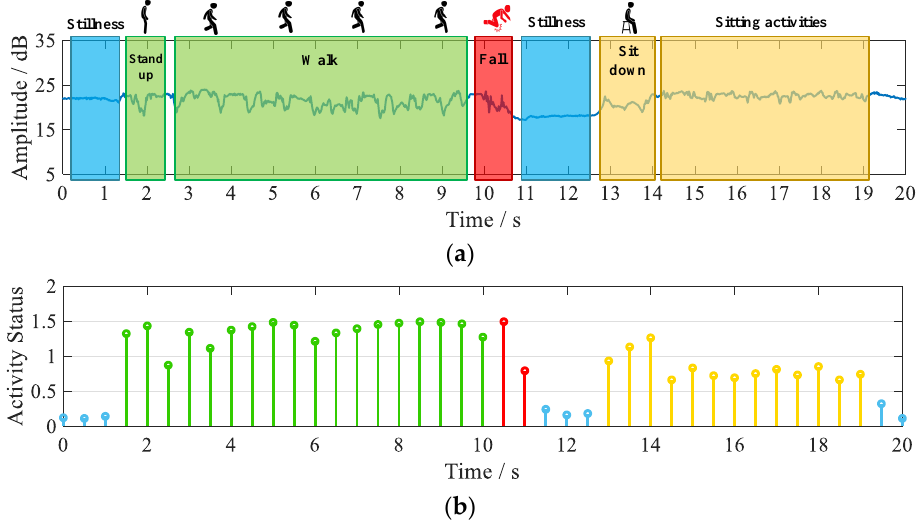
Figure 3. Human activity data: ( a ) human activity data; ( b ) human activity state diagram.